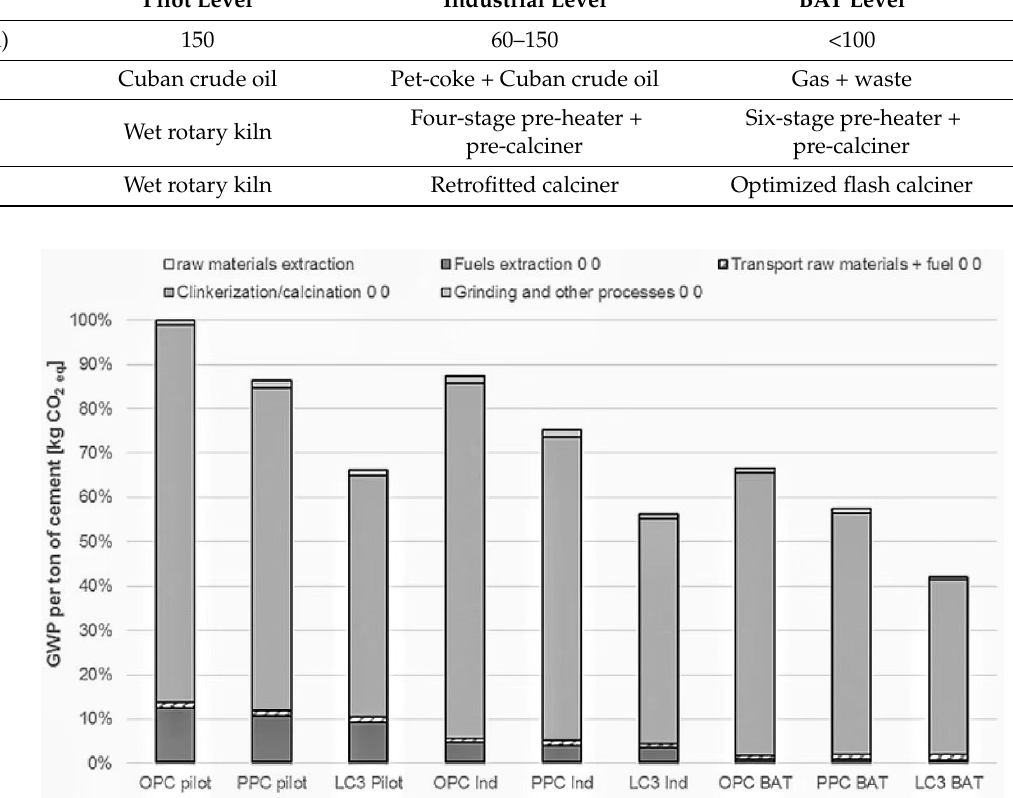
Figure 2. Potential impact of cement production on global warming in Cuba. Reprinted with permission from Ref. [3]. Copyright: 2018, Karen Scrivener. Published by